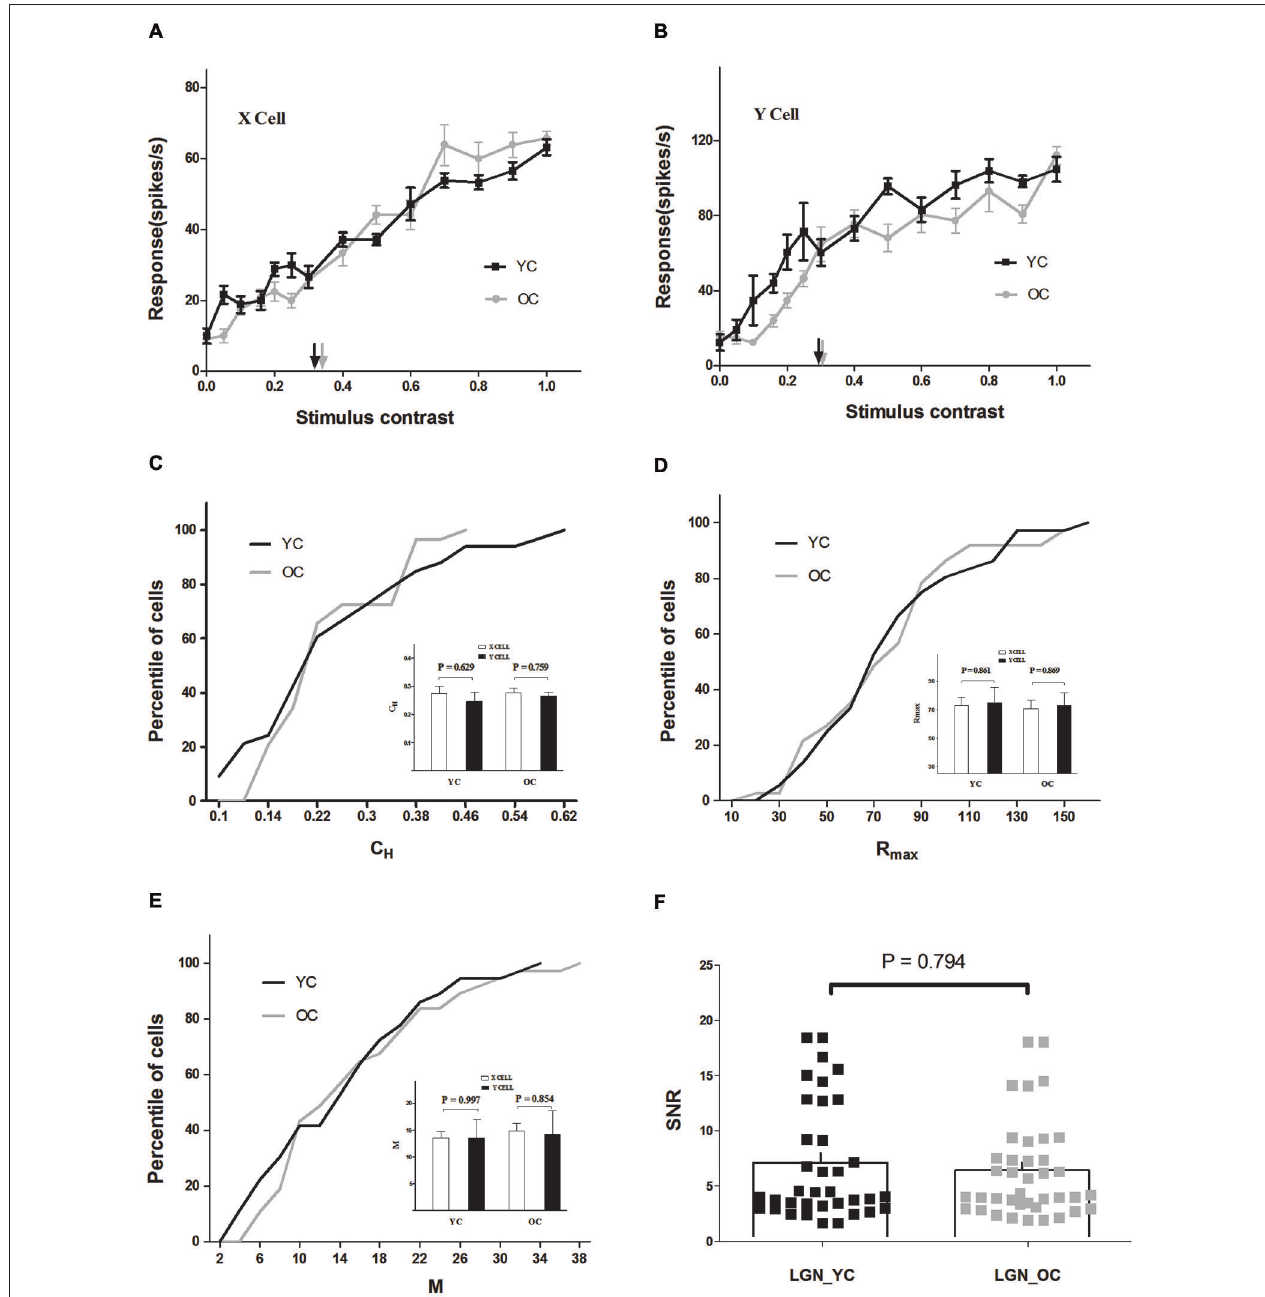
in C , D , and E . Comparison of each parameter between X and Y cells, in young and old cats, is shown on the inset plots in C , D , and E . Black and gray lines represent the data which combined X and Y cells of young and old cats, respectively. (F) Distribution of signal-to-noise ratio (SNR) values in LGN for young (black squares) and old (gray squares) cats. The histograms indicate the mean value of SNR values in each group. Error bars indicate SEM. The same abbreviations are used in subsequent